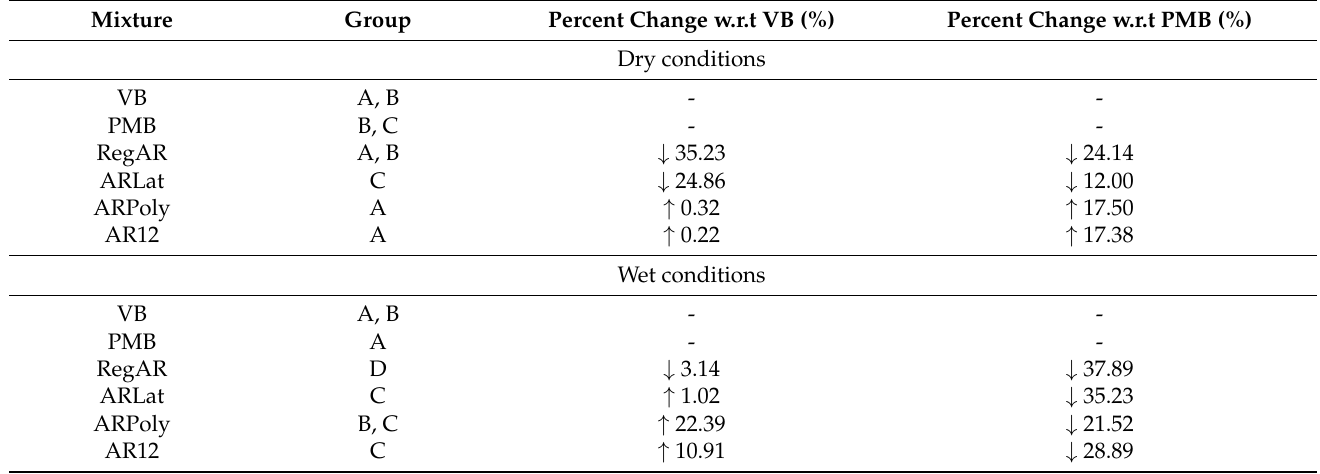
Table 7. Results of ANOVA analysis for toughness (parametric